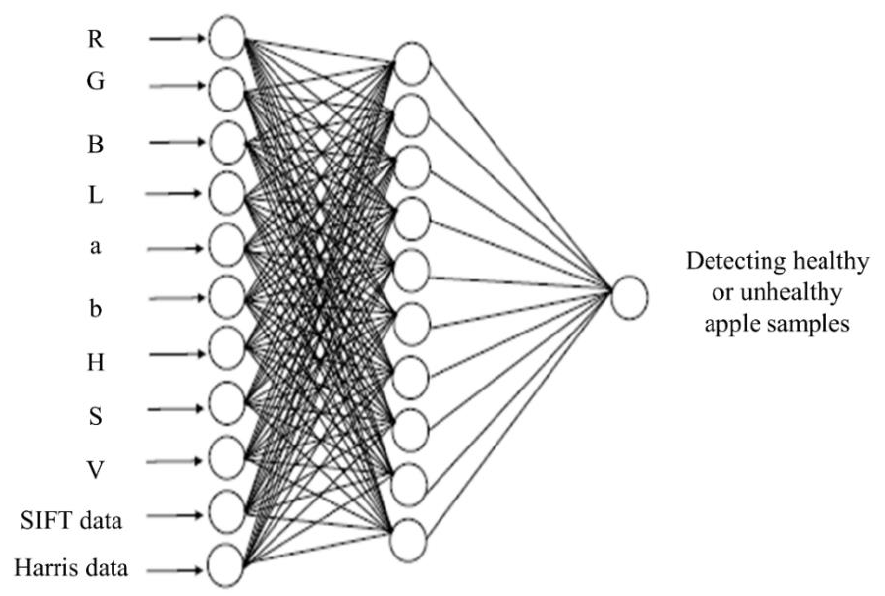
Figure 4. Architecture of used artificial neural network.